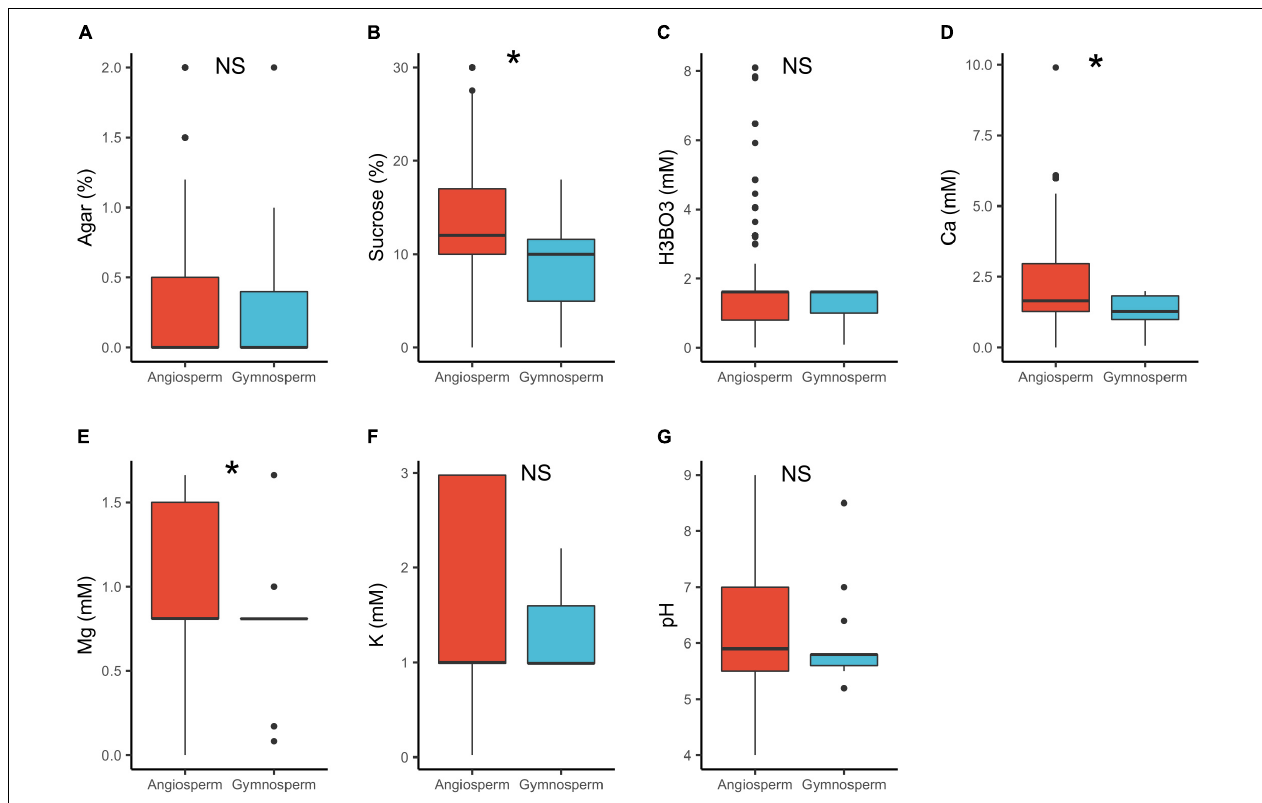
FIGURE 2 | Pollen germination media requirements for angiosperms ( n = 1092) and gymnosperms ( n = 46): agar (A) , sucrose (B) , boric acid (C) , calcium (D) , magnesium (E) , potassium (F) , and pH (G) . *, significant ( p < 0.05); NS, not significant.